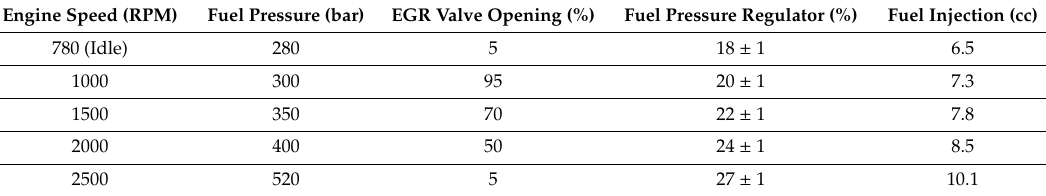
Table 4. Test conditions (Coolant temperature: 82 ± 2 ◦ C).